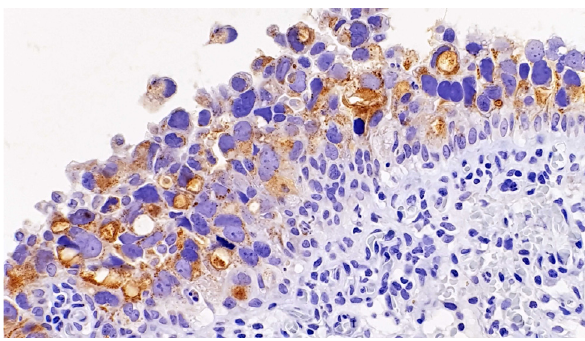
Fig. 3. Expression of CD24 in urothelial carcinoma in situ (mag- nification x400).